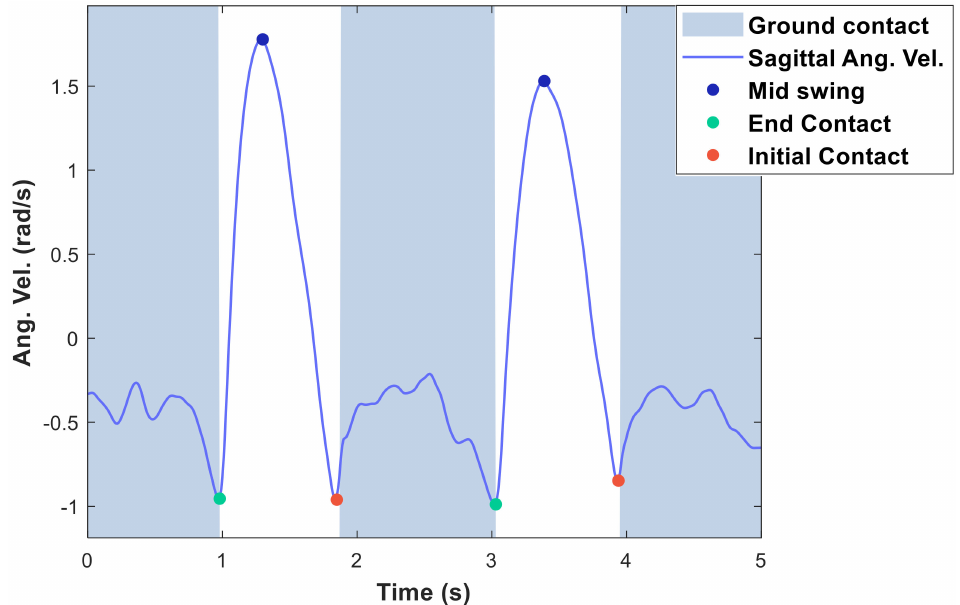
Figure 3. The peaks in the sagittal angular velocity of the cane corresponding with the end contact (green points), mid-swing (blue points), and initial contact (red points) of the